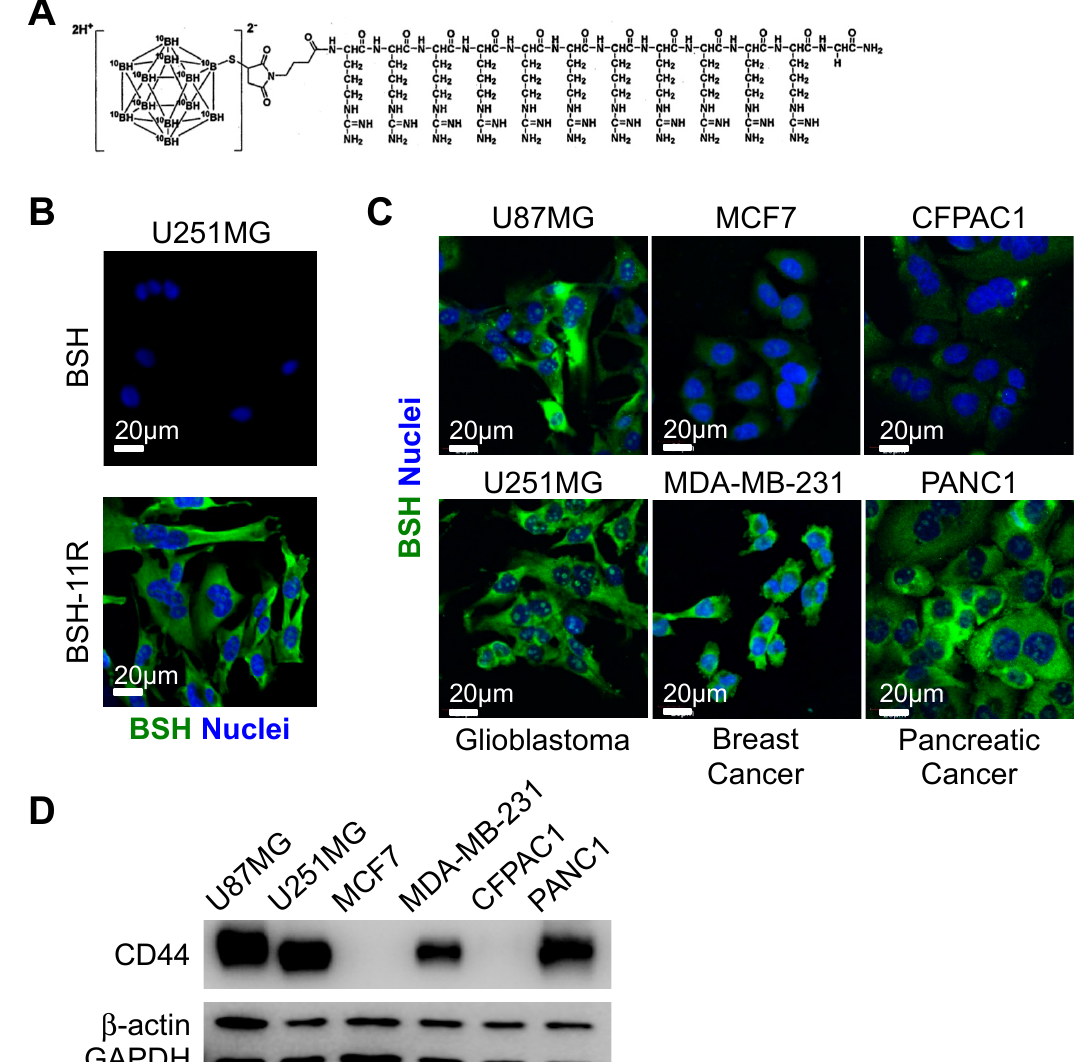
Figure 1. The enhanced cellular uptake of poly-arginine peptide mercaptoundecahydrododecaborate (BSH-polyR) correlates with the expression profile of cluster of differentiation 44 (CD44). ( A ) Scheme of BSH-11R. ( B ) BSH-11R, but not BSH, can penetrate the plasma membrane of U251MG cells. ( C ) BSH-11R efficiently penetrates the cellular membrane of U87MG, U251MG, MDA-MB-231, and PANC1 cells, but not MCF7 and CFPAC1. ( D ) The expression profile of CD44 is correlated with the efficacy of BSH-11R.